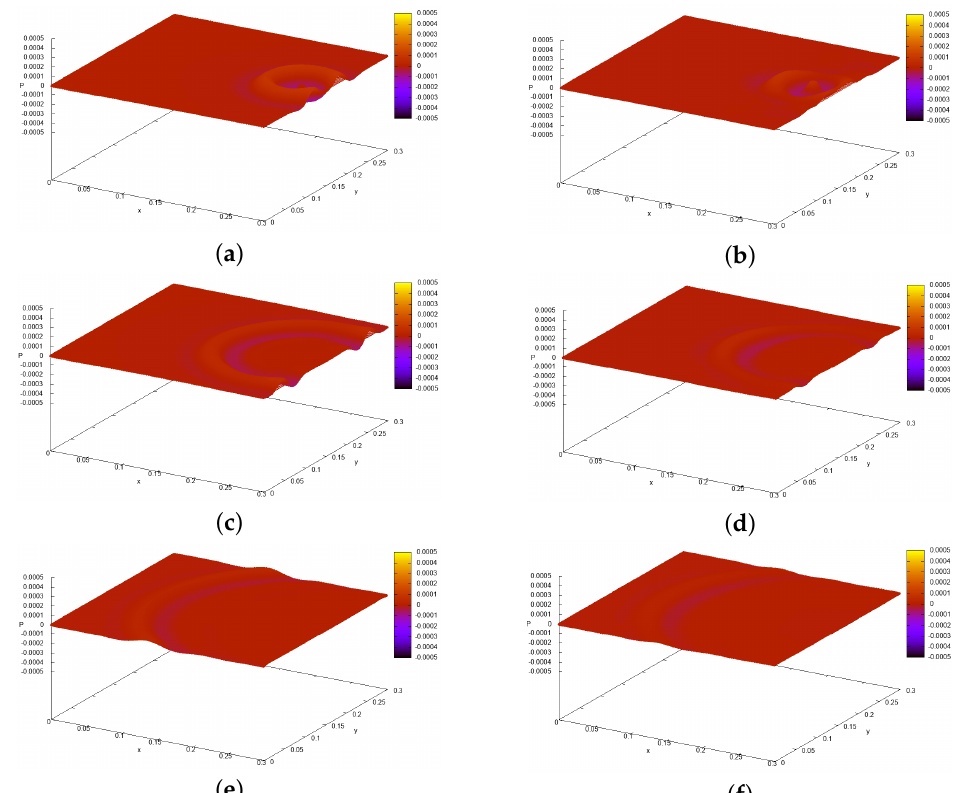
Figure 9. Test 3. Inverse problem 2. Numerical solution. 900 iterations. Left column ( a , c , e )— solution of the direct problem (1)–(5) with q 1 ( x , y ) = q 2 ( x , y ) = 0 (pressure distribution p ( x , y , t ) ). Right column ( b , d , f )—solution of the direct problem (1)–(5) with reconstructed functions q 1 ( x , y ) , q 2 ( x , y ) (pressure distribution p ( x , y , t ) ). 1),2)—pressure distribution at t = 0.06 ms; ( c , d )—pressure distribution at t = 0.11 ms; ( e , f )—pressure distribution at t = 0.16 ms.